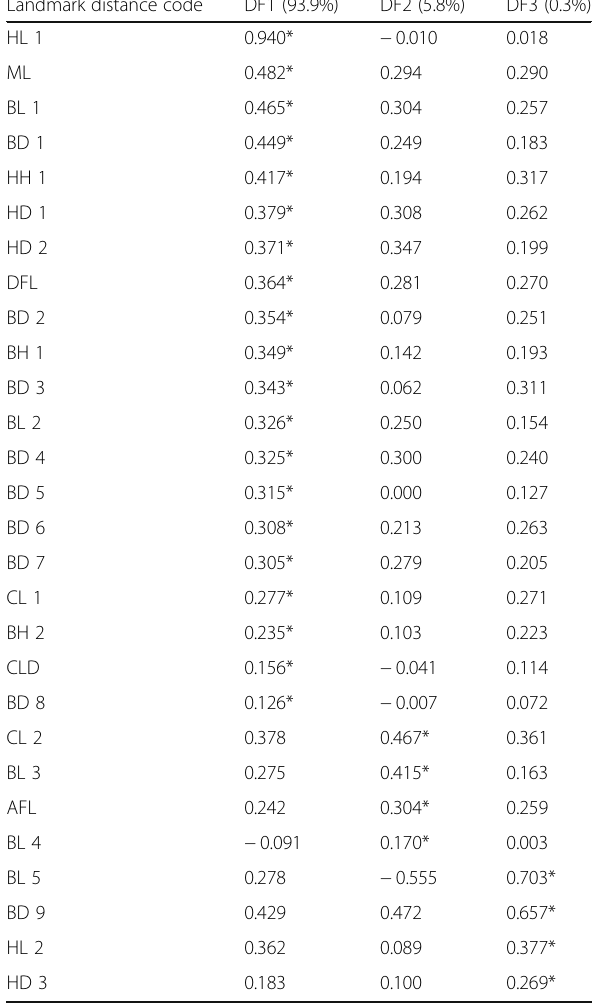
Table 7 Contribution of morphometric measurements to discriminant functions (DF) of A. clupeoides collected from the four sampling sites along the Bay of Bengal coast, Bangladesh Landmark distance code